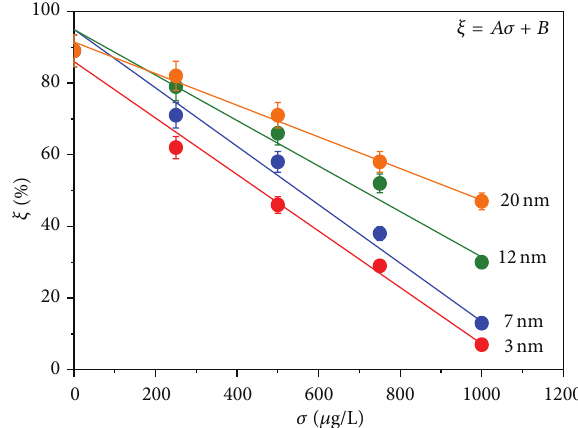
Figure 5: Variation of the ratio percentage of the number density of cells in CS ( 𝜉 ) of Mystus tengara with increasing ZnS nanoparticle concentration ( 𝜎 ) for a fixed exposure time ( 𝑡 = 60 days) keeping nanoparticle size ( 𝑑 ) as a